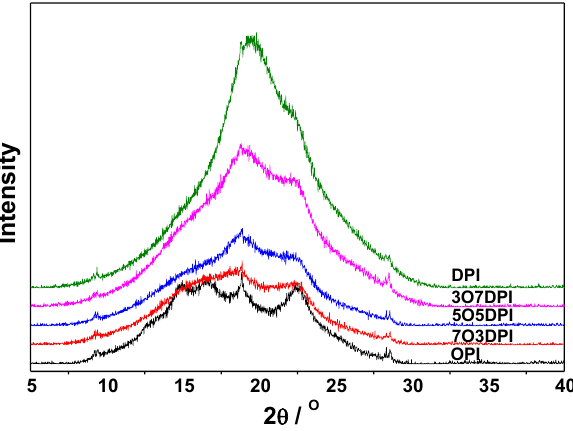
Figure 3. Wide-angle X-ray diffraction (WXRD) spectrum of the polyimide films.